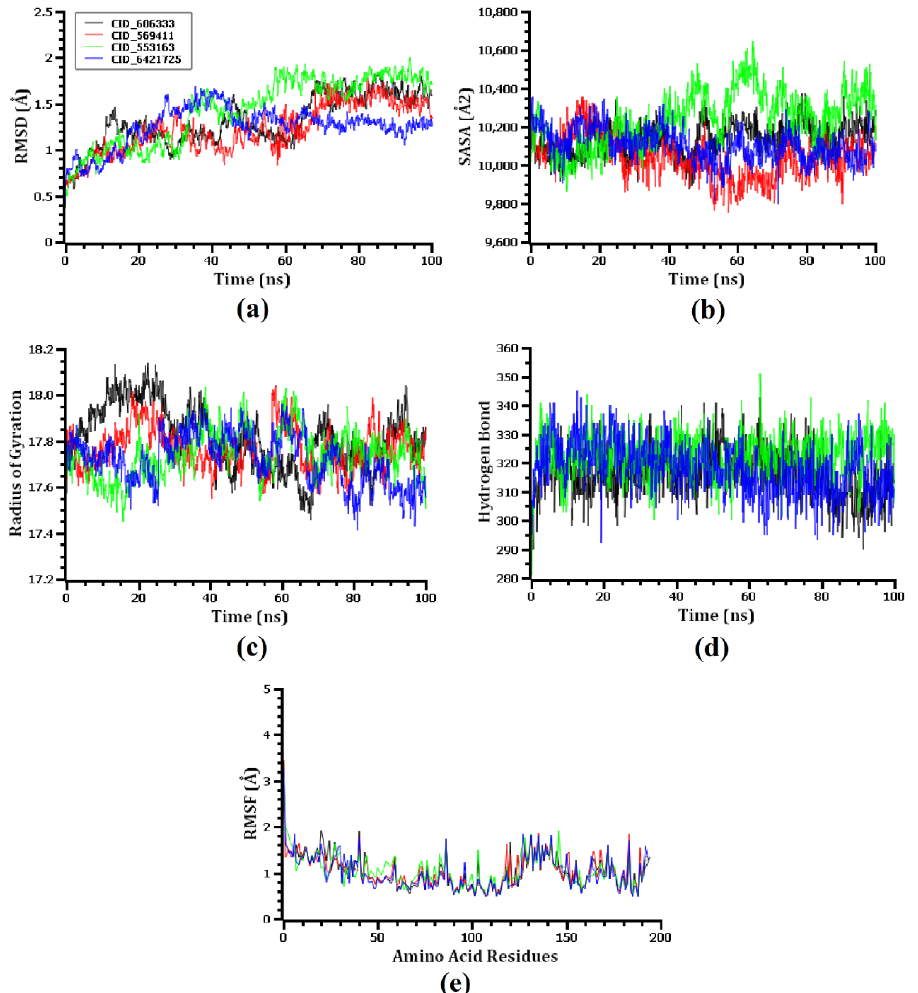
Figure 8. The molecular dynamics simulation study of the top four ligand molecules and 7M1M protein complex, here, ( a – e ) designates the RMSD, SASA, Rg, H-bond, and RMSF analysis of the complexes. Here, black color indicating CID 606333, red color indicating CID 569411, green color indicating CID 553163 and blue color indicating CID